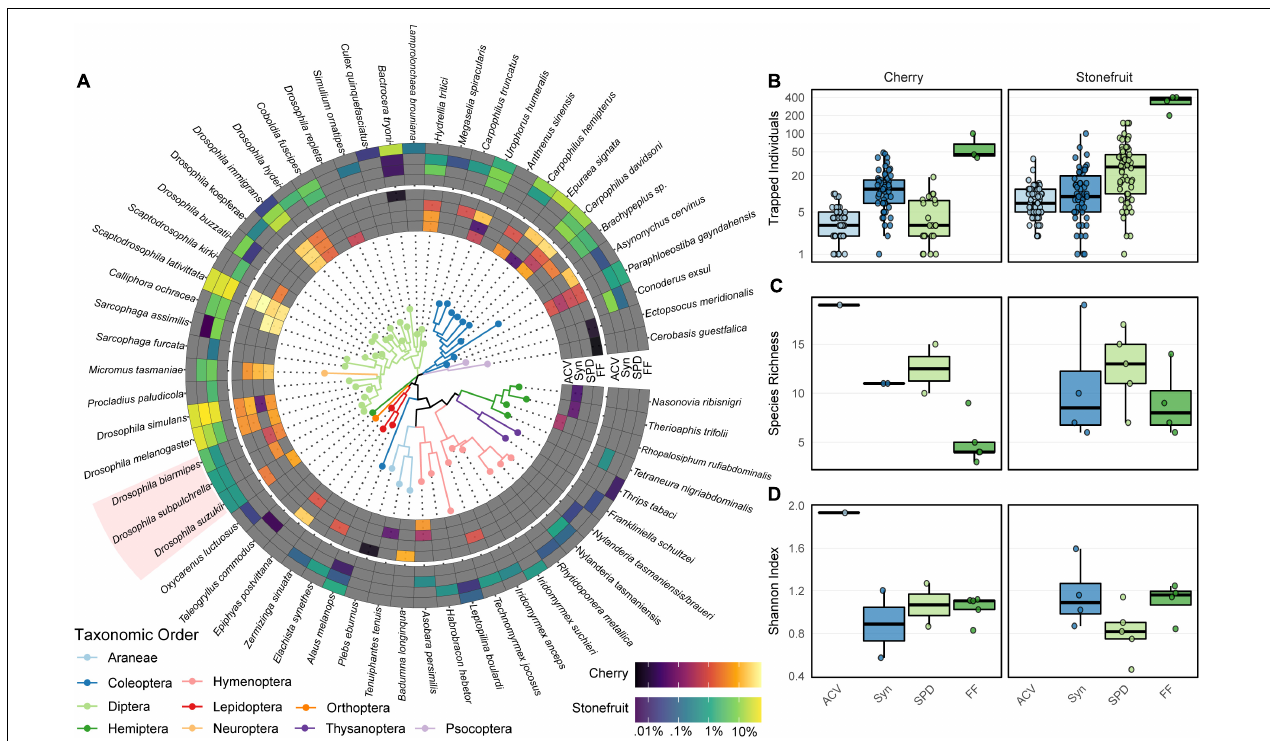
FIGURE 4 | (A) Phylogenetic relationships between all detected taxa in the field samples, with the mean relative read abundance (RRA) of each taxon displayed by sampling method for the cherry (inner heatmap) and stone fruit (outer heatmap) orchards. (B) Number of individual specimens collected from each orchard by each sampling strategy over the total course of the 10-week trapping period, displayed on a pseudo-log scale. (C) Species richness and (D) Shannon index for each community following metabarcoding. Spiked-in target species exotic to Australia highlighted in